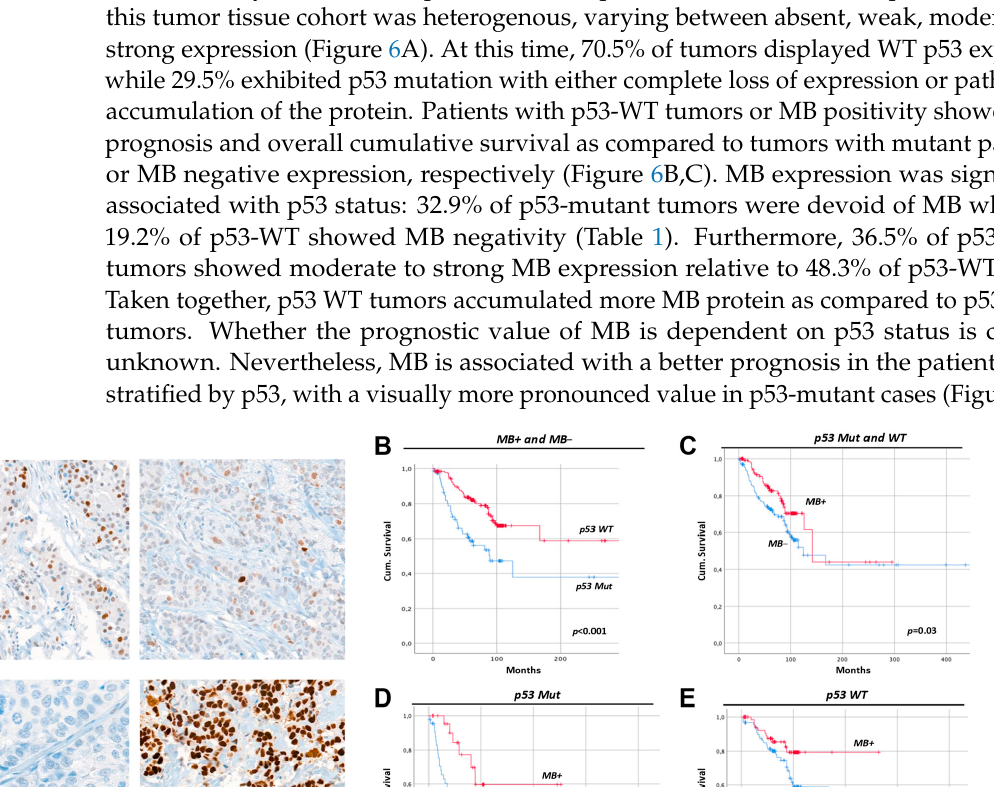
with MB − tumors, in p53 Mut as well as p53 WT cohorts,